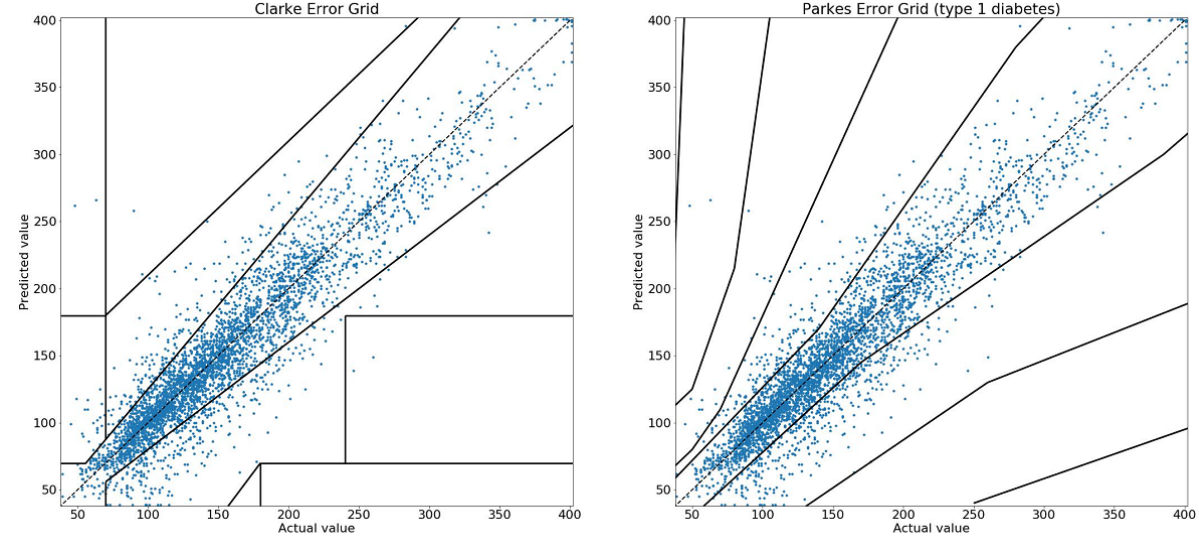
Figure 3. A sample scatter graph of blood glucose values predicted 30 min in advance by the Diabits model versus measured CGM values, plotted against Clarke (left) and Parkes (right) Error